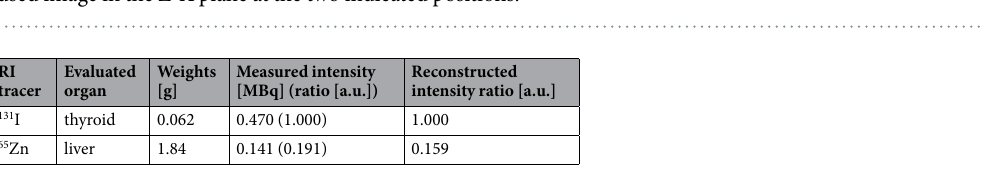
Figure 5. Results of representative 2-D slice in the Z-Y plane of 3-D mouse Imaging. ( a ) Image of 131 I, ( b ) 85 Sr, ( c ) 65 Zn, ( d ) fused images of all three tracers, and ( e ) the 3-D view image and the tomographic images of the fused image in the Z-X plane at the two indicated positions.